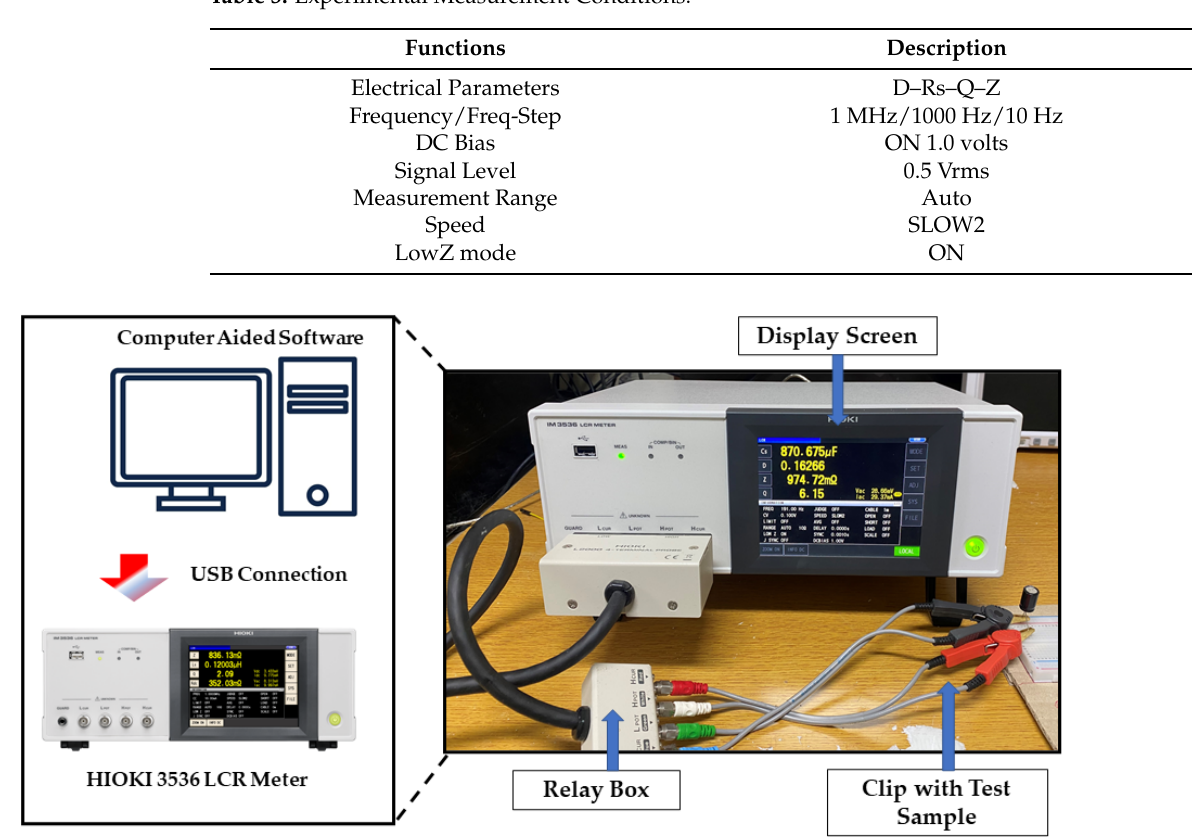
Figure 5. A detailed description of the connection used in data acquisition